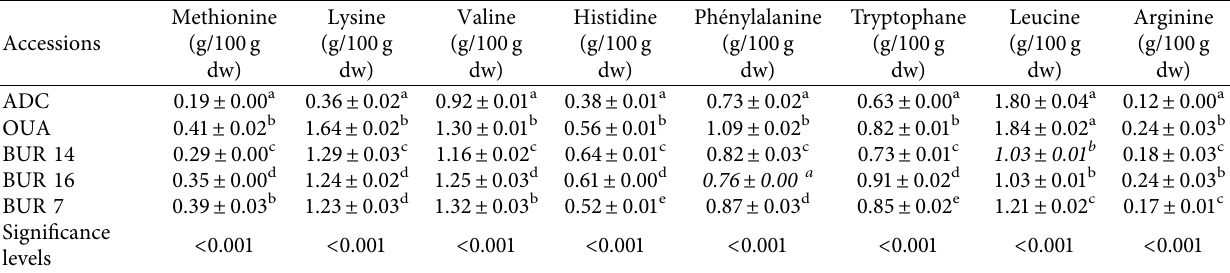
Table 4: Amino acids composition of Kersting’s groundnut seed (g) per 100g protein dry weight.